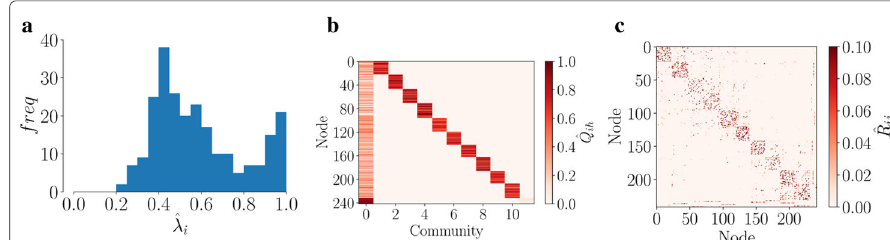
Fig. 13 Monte Carlo parameter identification (over 100 random link orientations) for the primary school case study. In ( a ), we show the distribution of the estimated parameter ˆ λ , which quantifies the role of communities in the network formation process. In average, half of the links are generated following the community structure. In ( b ), we plot the estimated community strength matrix ˆ Q . From the output, we observe that all the students have a large involvement in their classes, whereas teachers are more active in the all-to-all community than in the teacher community. In ( c ), we plot the estimated irreducible backbone of the network ˆ R . We observe that the network is sparse, and most of the nonzero terms are within the classes. These dyadic relationships may represent, e.g., students who sit next to each